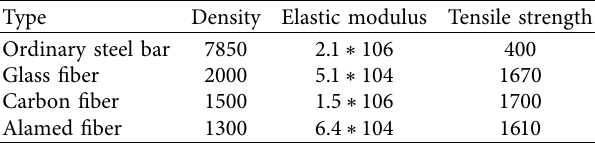
Table 1: FRP nano-inorganic composite material